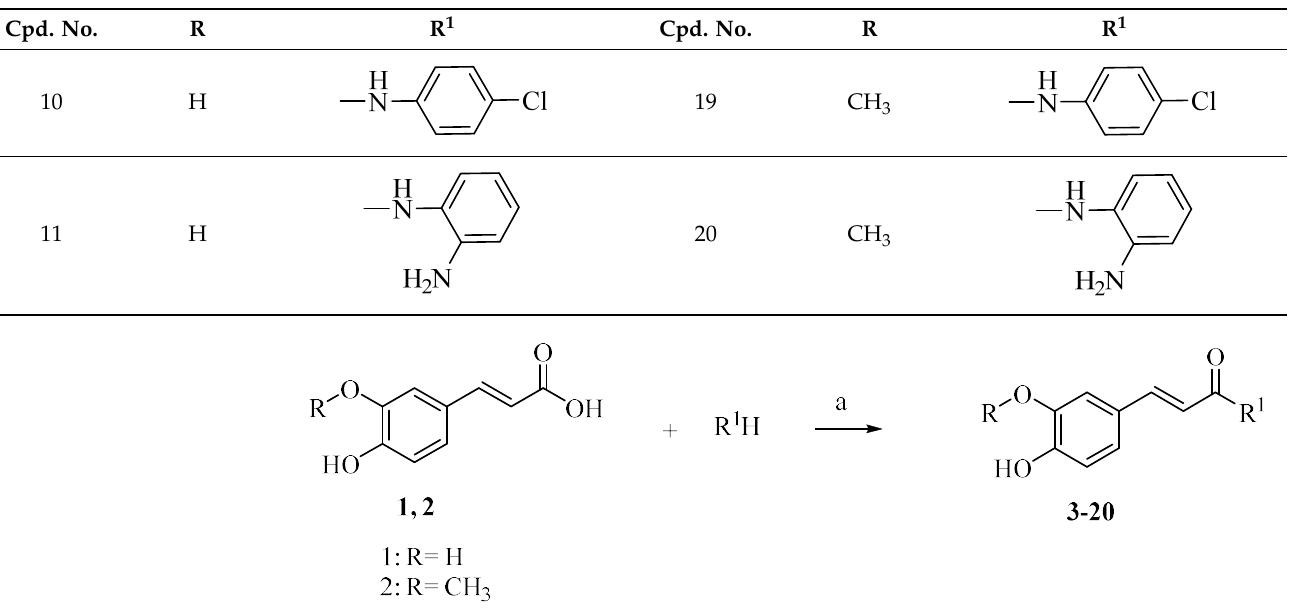
Figure 3. Scheme for the preparation of the candidate compounds. Table 1. Detailed structure of the semi synthesized compounds 3 – 20 .